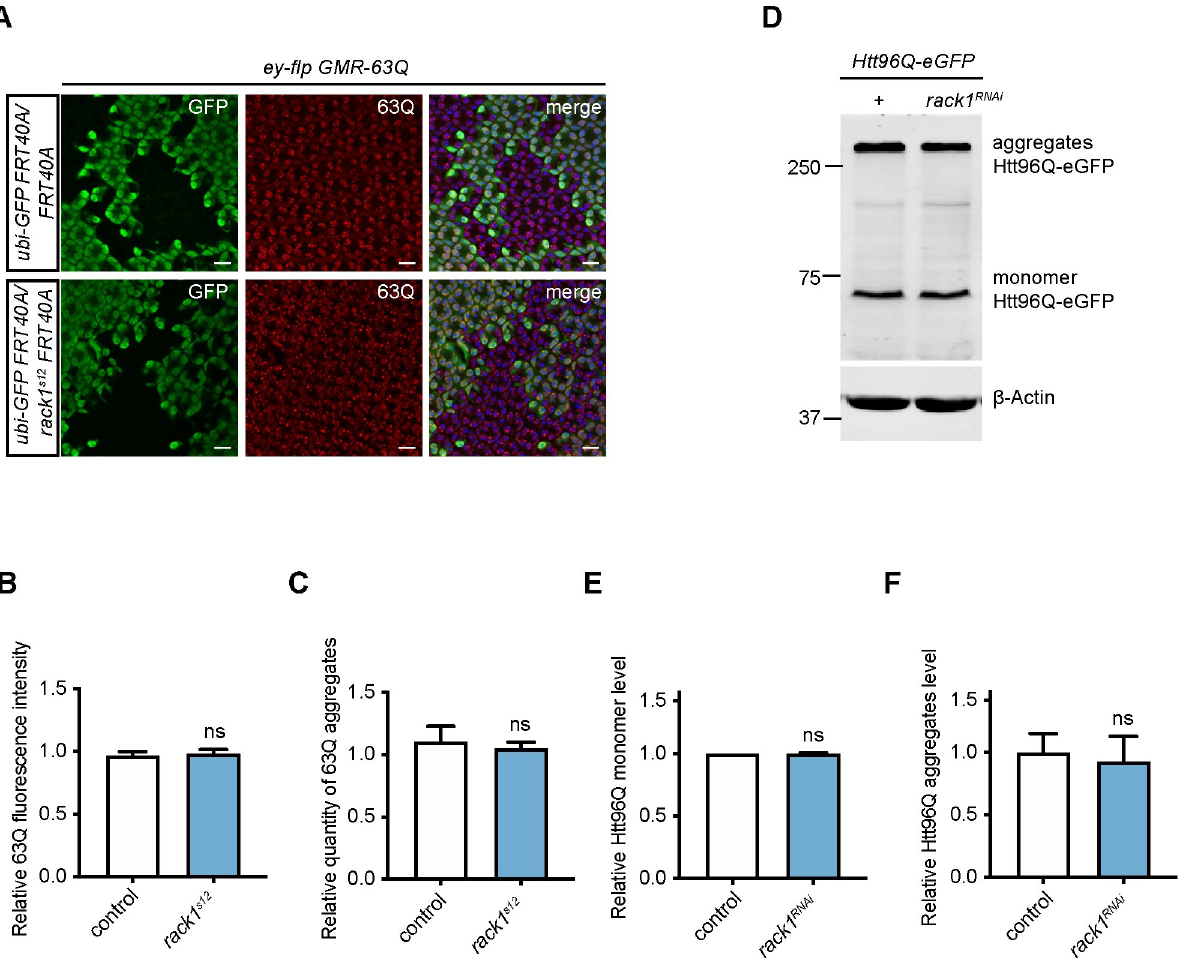
Fig 2. Loss of rack1 suppresses polyQ toxicity independent of aggregates clearance. (A) Pupa eye staining of control ( hs-flp GMR-63Q-HA; FRT40A/ubi-GFP FRT40A ) and rack1 s12 ( hs-flp GMR-63Q-HA;rack1 s12 FRT40A/ubi-GFP FRT40A ) mosaic clones by anti-GFP and anti-HA antibodies. GFP negative cells are rack1 homozygous mutant cells. Scale bar: 10 μ m. (B-C) Quantification of relative 63Q fluorescence intensity (B) and quantity of 63Q aggregates (C) in rack1 s12 mutant clones compared to GFP-positive control counterparts in panels A (Student’s unpaired t test, n = 5). Data are presented as mean ± SEM. (D) Western blot analysis of monomer and aggregate form of Htt96Q proteins extracted from fly eyes with antibody against GFP. β -Actin was used as a loading control. (E-F) Fold-change of Htt96Q monomer (E) and aggregates (F) level in GMR > Htt96Q , rack1 RNAi ( GMR-GAL4/+;UAS-Htt96Q-eGFP/UAS-rack1 GD12135 ) flies compared to GMR > Htt96Q ( GMR-GAL4/+;UAS-Htt96Q-eGFP/+ ) flies (n = 3). ns: not significant (Student’s unpaired t test). Data are presented as mean ± SEM.